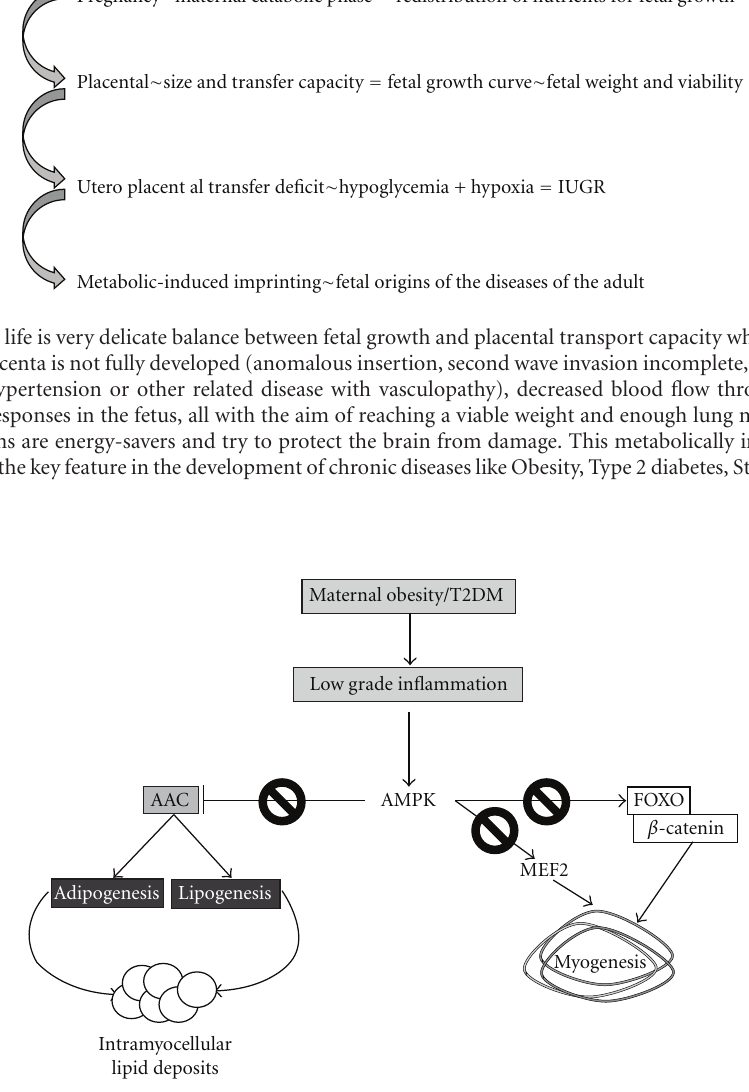
Figure 4: If the baby develops in a proinflammatory milieu, it is another study. The Barker hypothesis comes with an inflammatory component but it is basically aimed at the mother due to placental hypoxia (it is basically responsible for the hypertension and prothrombotic features of Preeclampsia). In the Macrosomic fetus low-grade inflammation takes it is toll on AMPK activation, which due to it is inhibition 2 basic pathways are modified. First, Acetyl ∼ CoA loss of inhibition, which lets loose adipogenesis and lipogenesis with increased intramyocellular lipid deposits. Second, while preadipocyte is di ff erentiated to mature adipocytes, myogenesis is being stalled due to loss of activation of expression of genes that regulate myocyte development. FOXO : nuclear transcription factor; MEF2 : myocyte enhancer